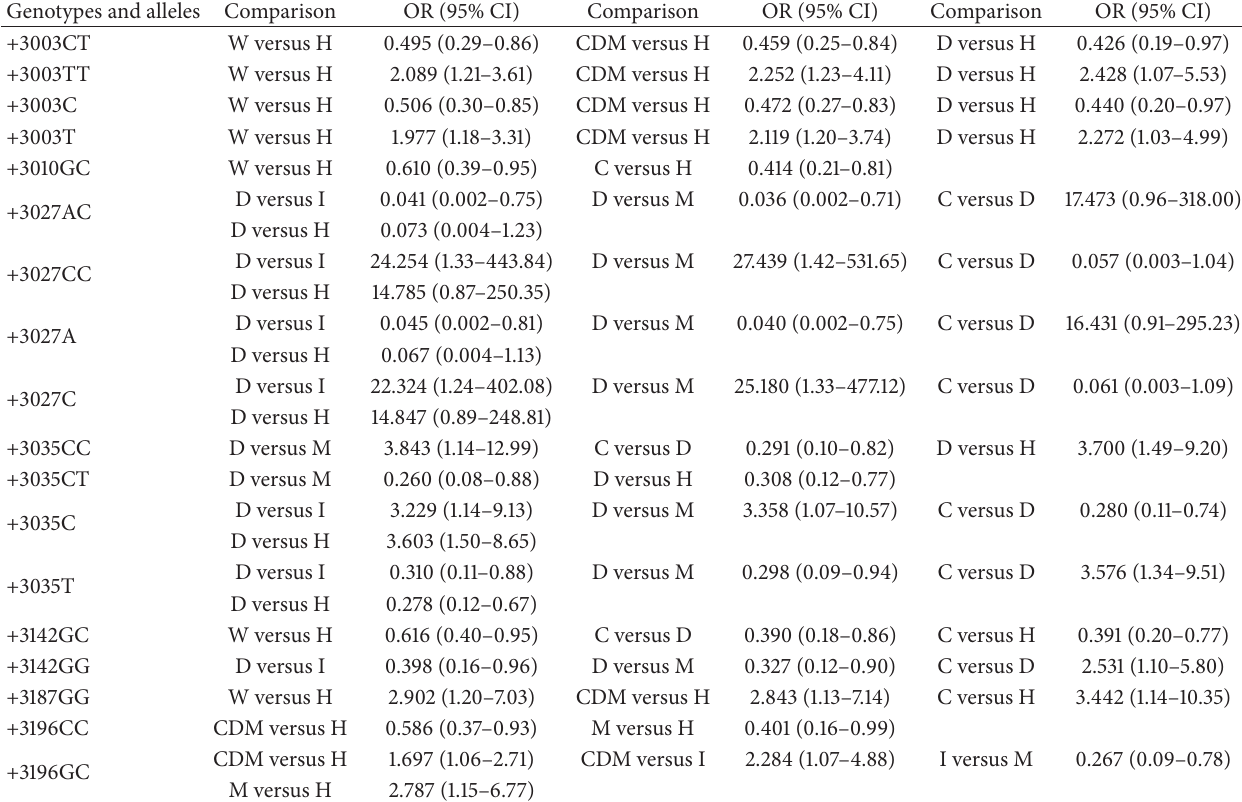
Table 2: Odds Ratio and 95% Confidence Interval values obtained from the comparisons of genotype and allele frequencies of variation sites at HLA - G 3 󸀠 untranslated region (3 󸀠 UTR) between different presentation forms of Chagas disease and healthy controls. Genotypes and alleles Comparison OR (95% CI)